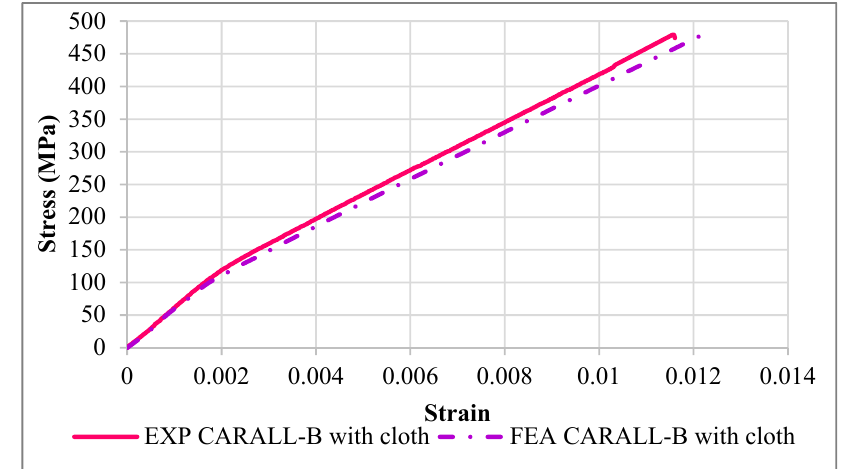
Figure 32. FEA and experimental stress-strain plots for CARALL-B specimens having veil cloth.